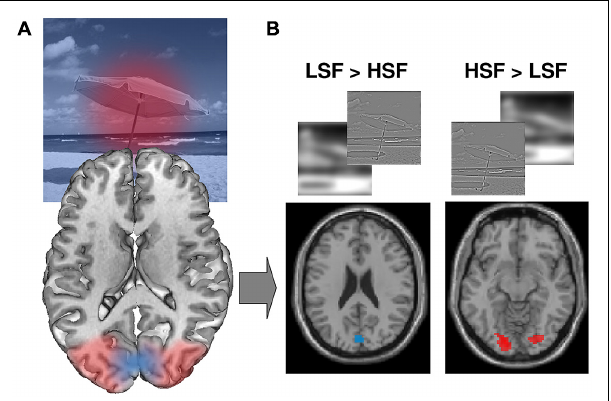
FIGURE 4 | (A) Retinotopic mapping of the visual field on the visual cortex. The central (foveal) part of the visual field is represented at the very back of the visual cortex and laterally. More peripheral regions of the visual field are represented further forward in the medial part of the visual cortex. (B) Retinotopic organization of spatial frequency processing during scene perception: LSF [as opposed to HSF, (LSF > HSF) contrast] scene categorization recruits areas dedicated to peripheral vision, while HSF [as opposed to LSF, (LSF > HSF) contrast] scene categorization recruits areas dedicated to foveal vision. Figure adapted from Musel etal.